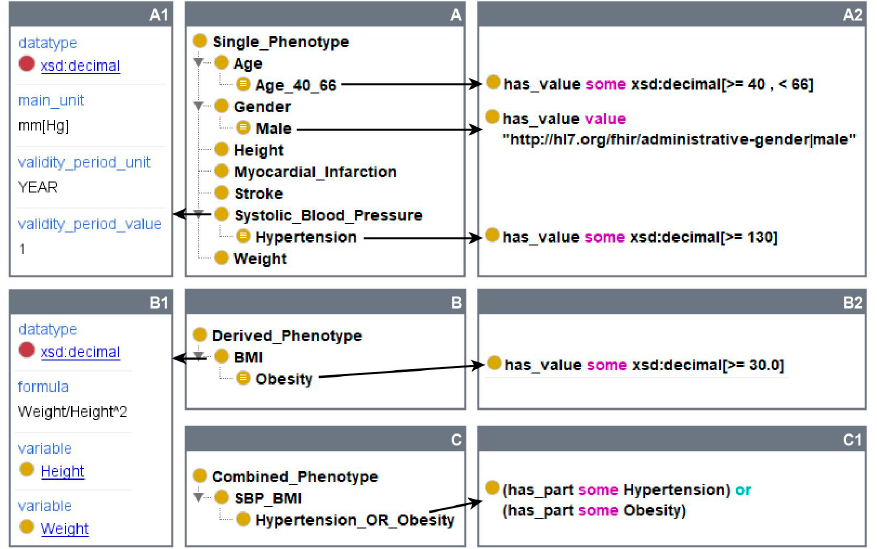
Figure 2. An example PheSO (some excerpts from the OWL representation and Protégé [25] screen- shots). Subfigures ( A – C ) show all single, derived, and combined phenotype classes in the PheSO, respectively. ( A1 , B1 ) show annotations of the classes “Systolic_Blood_Pressure” and “BMI”. ( A2 , B2 , C1 ) show Manchester Syntax expressions for selected phenotype classes. The full ontology is available as Supplementary Material File S1 and at https://health-atlas.de/lha/8ATHQGDE4F-4 (accessed on 19 May 2022).